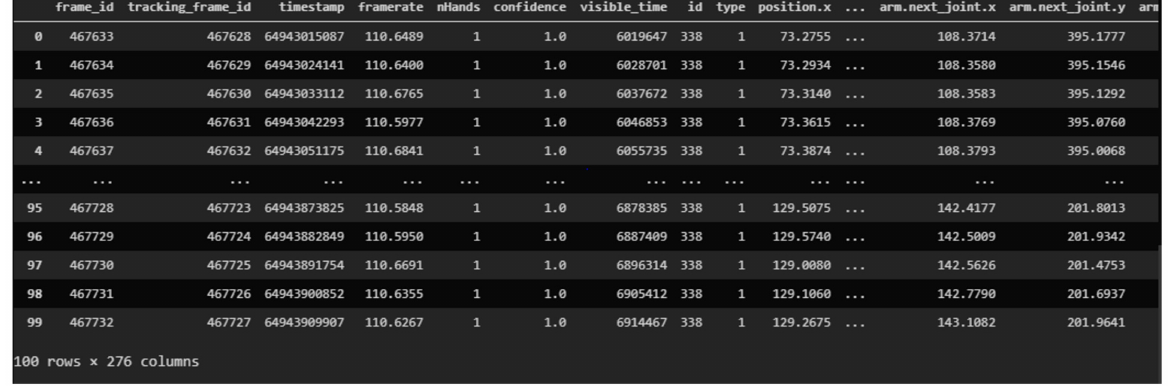
Figure 3. Hello sign